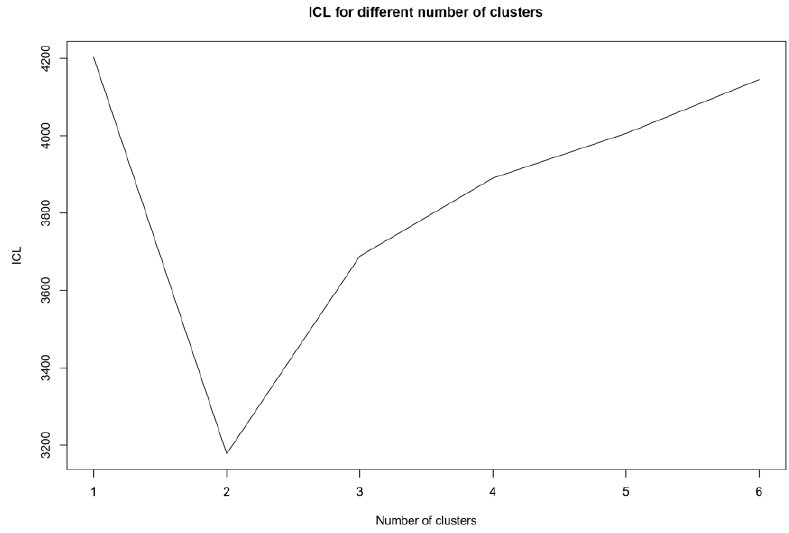
Figure 1. ICL determination of number of clusters.